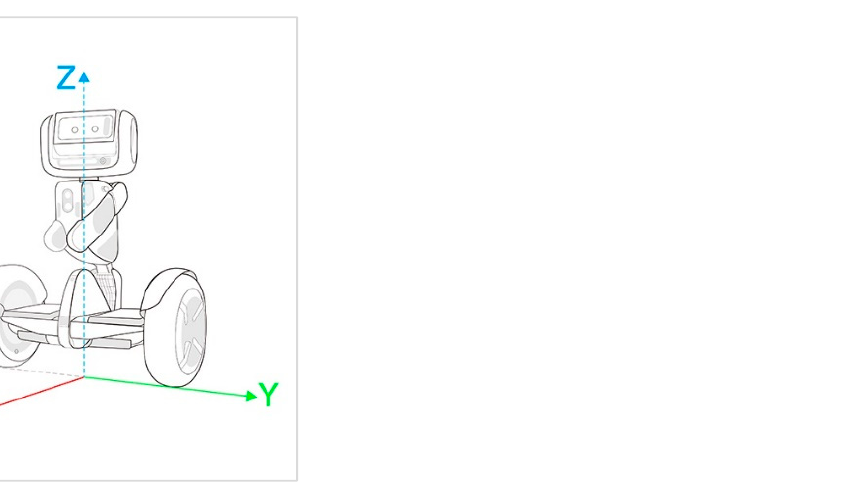
Figure 8. Robot body reference frame at the navigation layer: X and Y represent the linear velocity and Z represents the angular velocity [28].